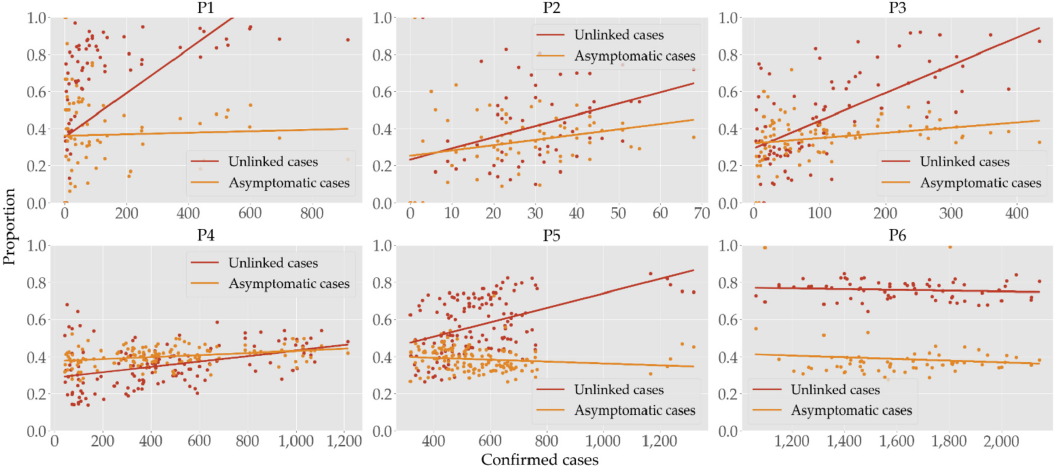
Figure 2. Scatter plots of daily confirmed cases versus the rates of unlinked (red) and asymptomatic (orange) cases. Visually comparing the slopes of regression lines across different periods can be misleading since the horizontal axes are not of the same scale.